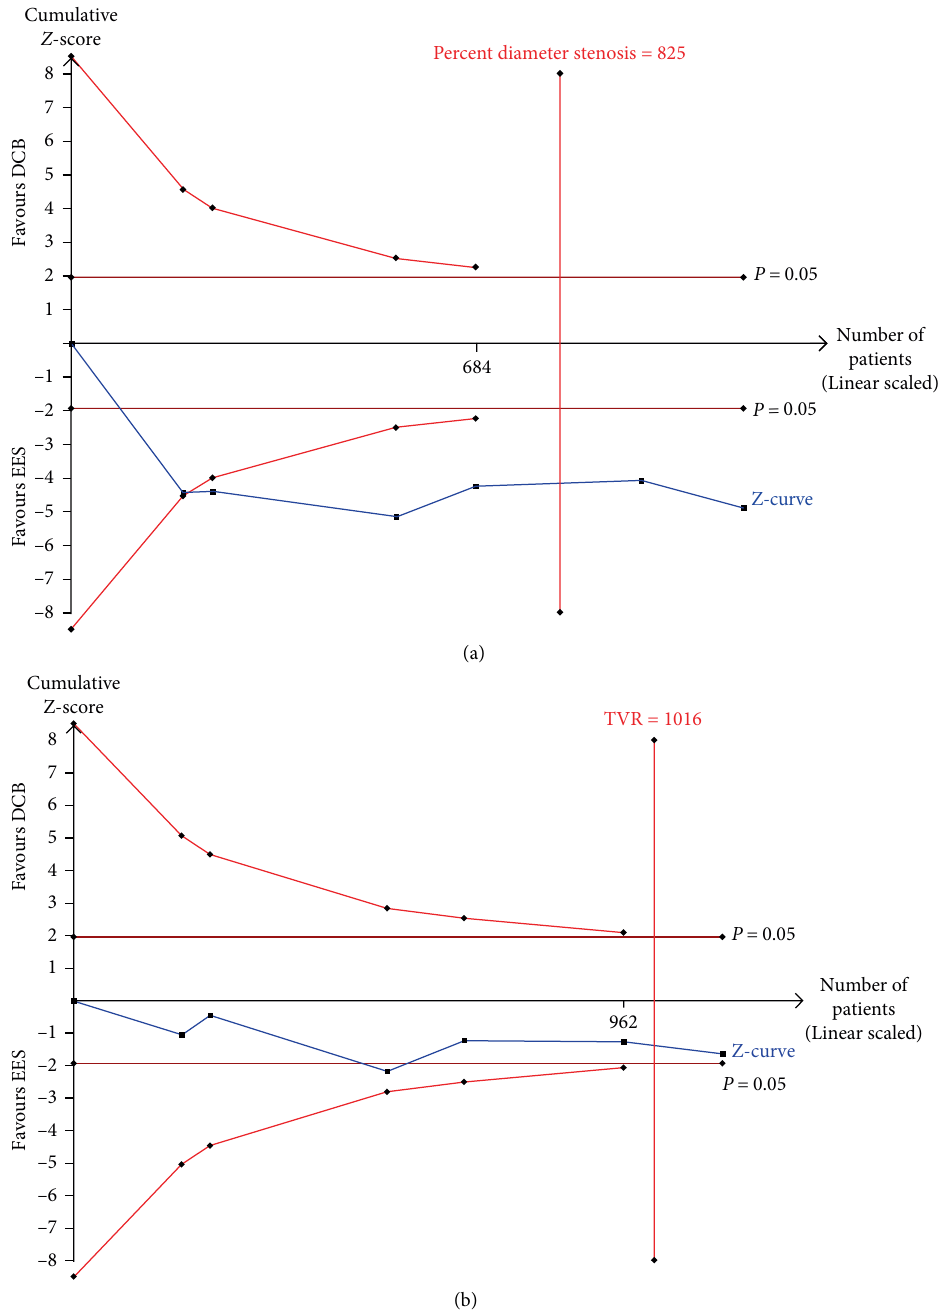
Figure 3: The trial sequential meta-analysis (TSA) of DCB versus EES for the treatment of in-stent restenosis on percent diameter stenosis (a) and target vessel revascularization (b). DCB, drug-coated balloons; EES, everolimus-eluting